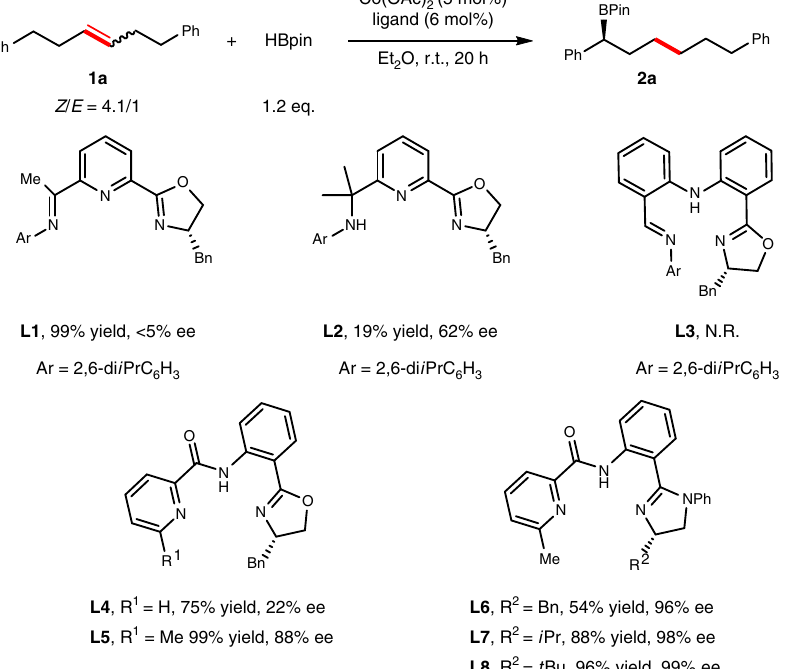
Fig. 2 Ligands screen for asymmetric isomerization/hydroboration. Reaction conditions: 1a (1 mmol), HBpin (1.2 mmol), Co(OAc) 2 (5.0 mol%), ligand (6.0 mol%), Et 2 O (1 M), r.t., 20